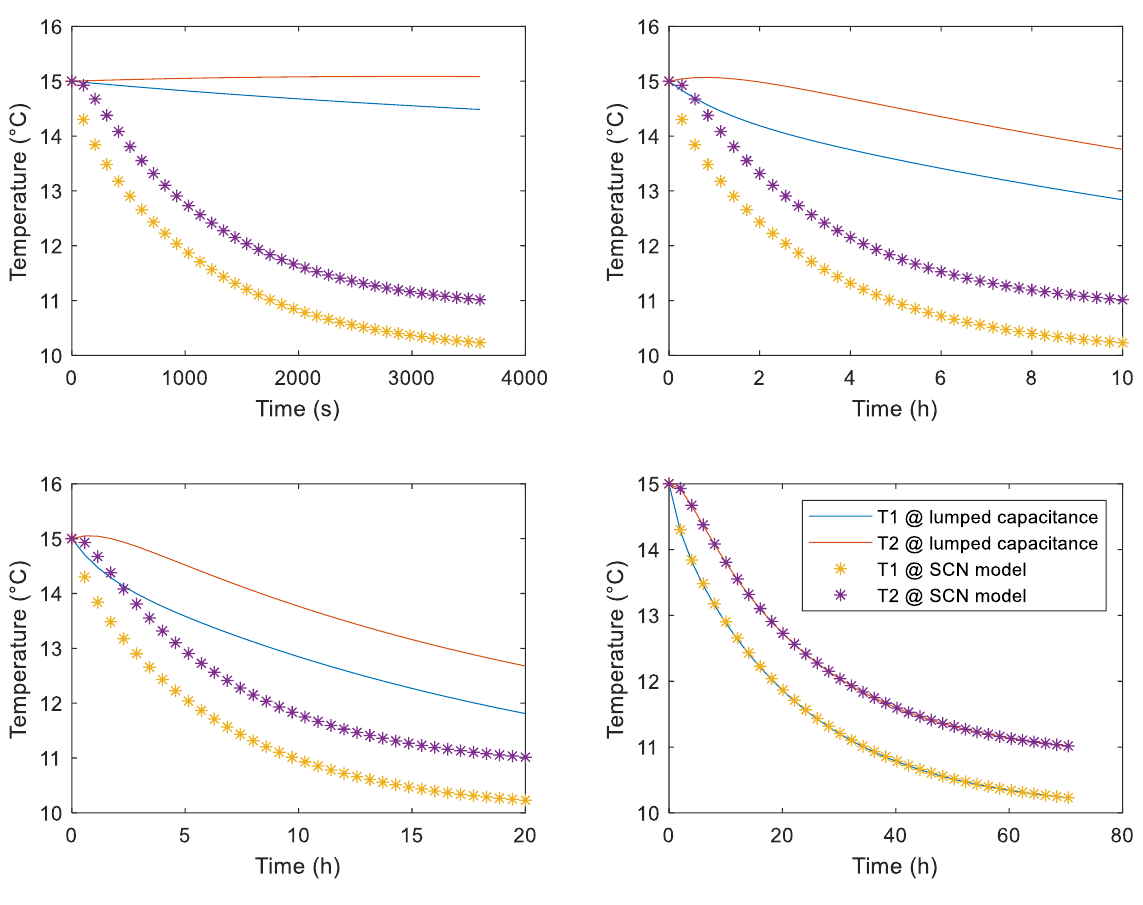
Figure 6. Model adjustment by numerical simulation for M = 36.